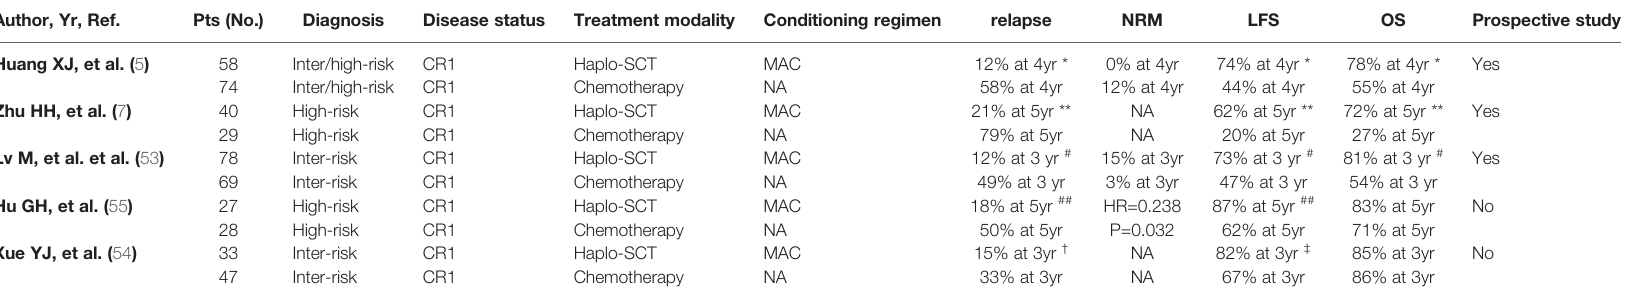
*P<0.01 for relapse, LFS and OS compared between haplo-SCT and chemotherapy. **P<0.01 for relapse, LFS and OS compared between haplo-SCT and chemotherapy.